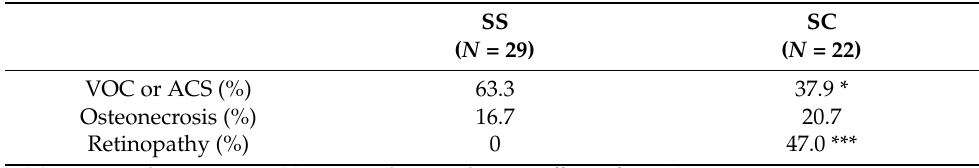
Table 2. Clinical complications in untreated SS and SC patients over 5 years of age.